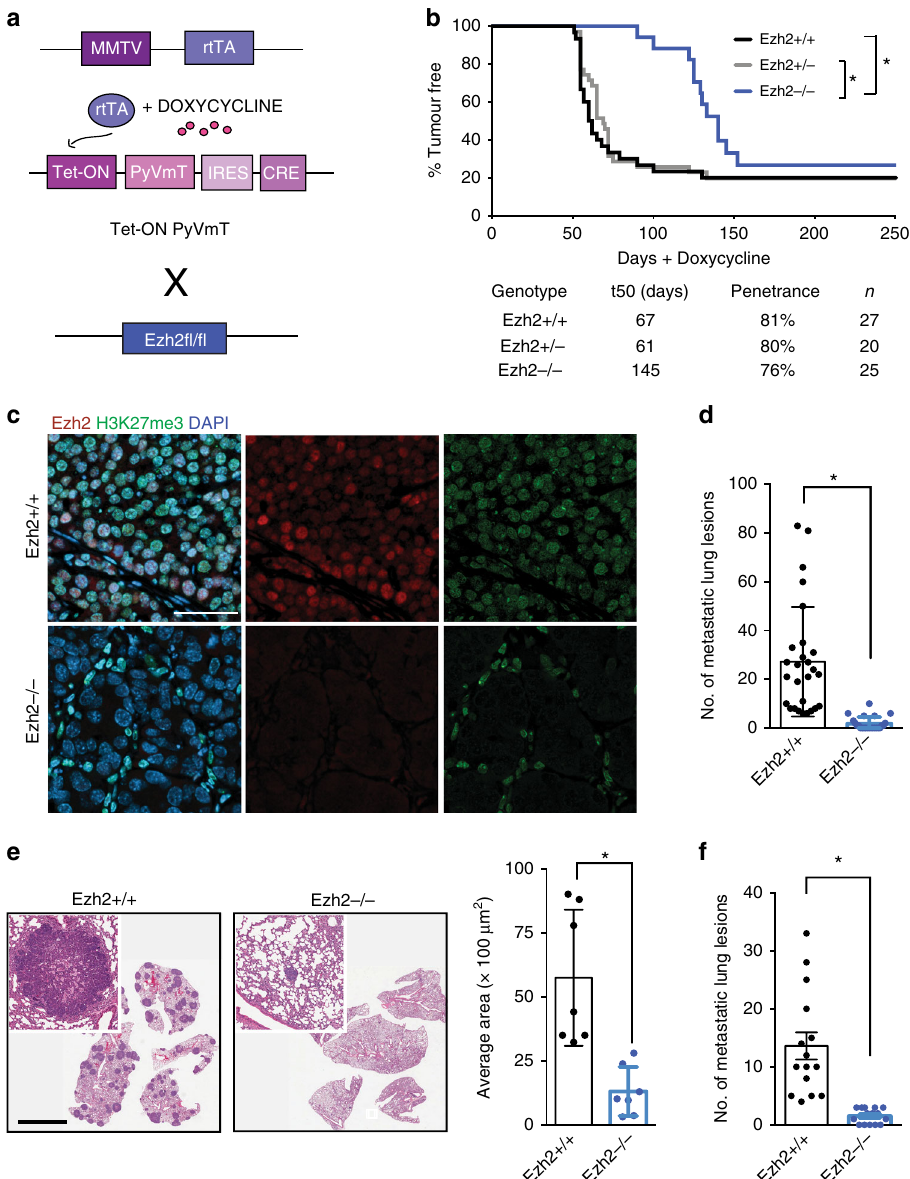
Fig. 1 Loss of Ezh2 signi fi cantly alters breast cancer tumorigenicity. a Schematic of the transgenic mouse model. b Kaplan – Meier survival curve of mammary tumour onset in Tet-ON PyVmT mice with wild-type (Ezh2 + / + , n = 27), heterozygous (Ezh2 + / − , n = 20) or homozygous (Ezh2 − / − , n = 25) Ezh2 conditional alleles. * p < 0.05, log rank test. c Immuno fl uorescence staining of endpoint Ezh2 + / + or Ezh2 − / − Tet-ON PyVmT tumours for Ezh2, H3K27me3 or the nuclear stain DAPI. Scale bar is 50 μ m. d Average number of metastatic lung lesions from tumour burden endpoint Tet-ON PyVmT mice (Ezh2 − / − , n = 25, Ezh2 + / + , n = 27). * p < 0.05, Student ’ s two tailed t -test. e Representative images of hematoxylin and eosin stained sections of paraf fi n- embedded lungs from Tet-ON PyVmT mice at tumour burden endpoint. Scale bar is 5 mm. Average area of lung lesions per genotype. * p < 0.05, Student ’ s two tailed t -test. f Quanti fi cation of lung lesions following tail vein injections of freshly dissociated cells from Ezh2 + / + or Ezh2 − / − Tet-ON PyVmT tumours into athymic nude hosts. Mice were killed after 8 weeks and maintained on water supplemented with doxycycline for the duration of the experiment. n = 15 for each genotype. * p < 0.05, two tailed t